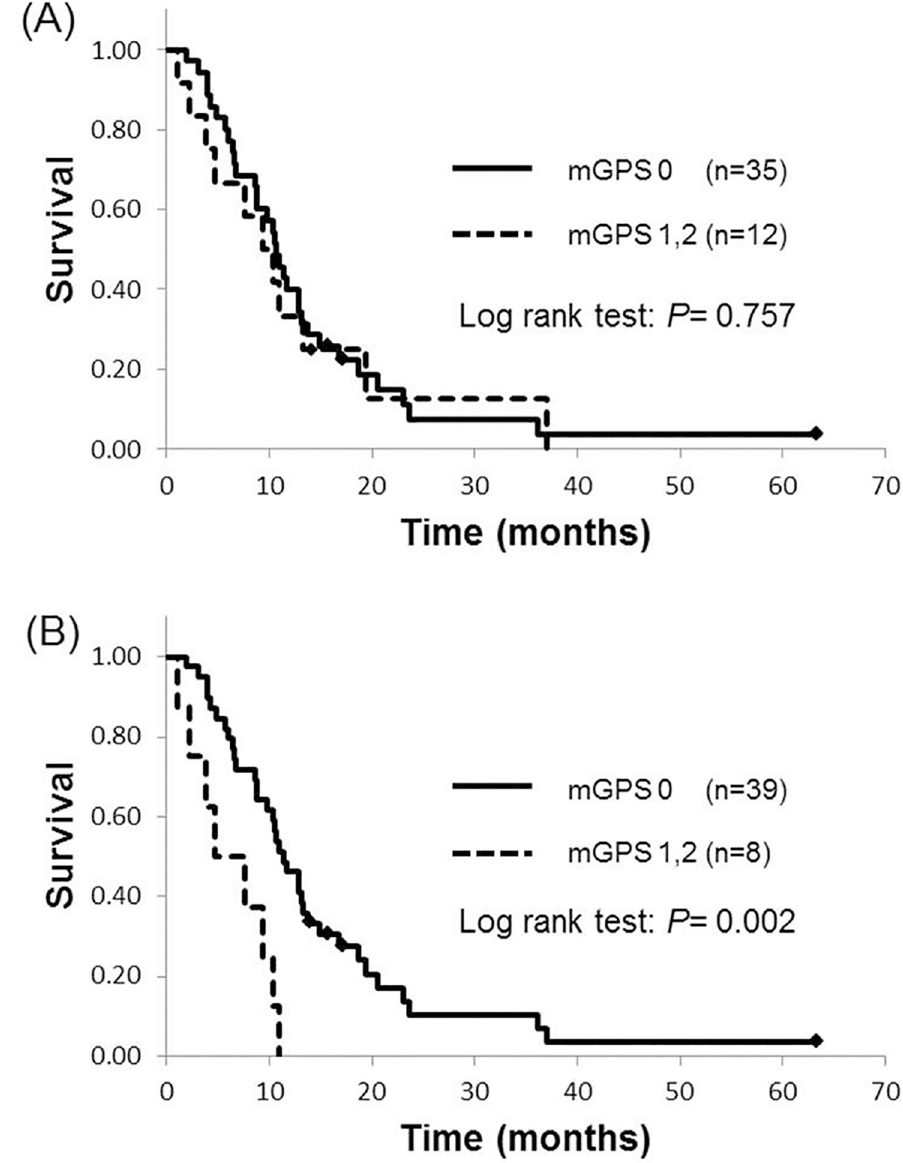
Fig 1. Kaplan-Meier curves for overall survival by mGPS values obtained prior to biliary drainage A) and after biliary drainage B).